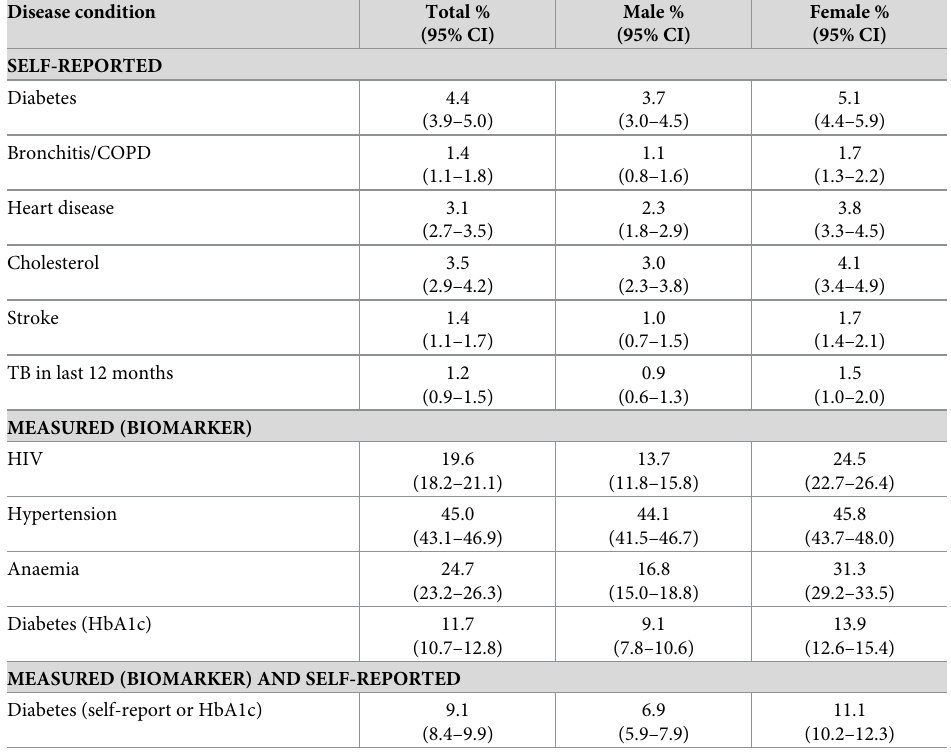
Table 4. Prevalence of single disease conditions by sex and method of measurement in South Africa for 2016 (weighted